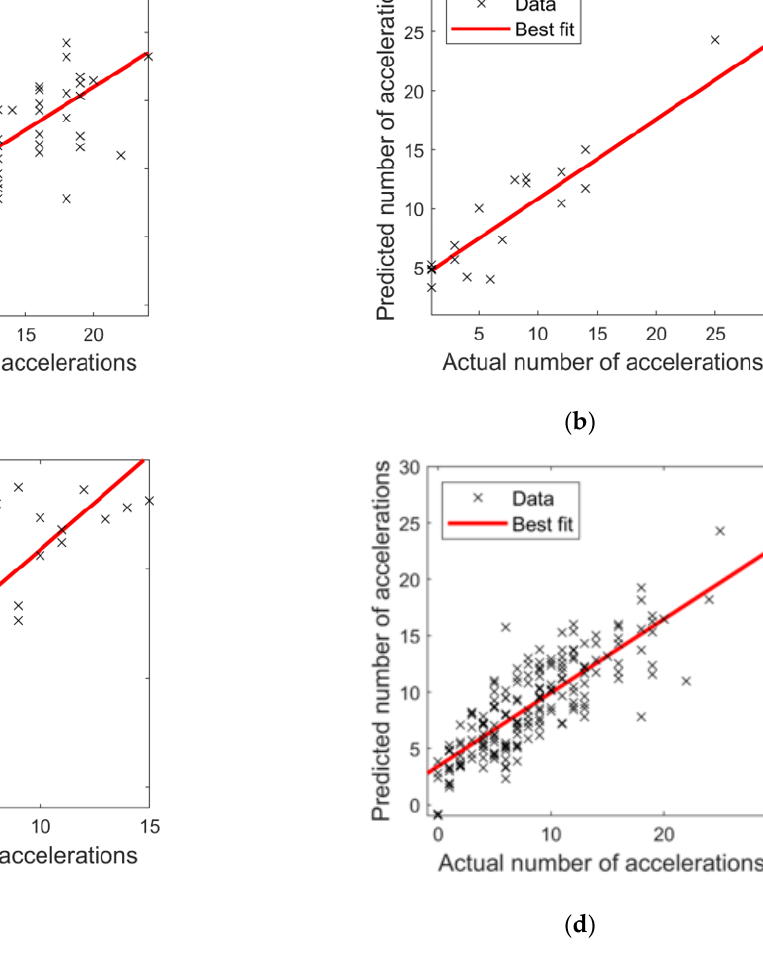
Figure 7. Scatter plots of the number of actual versus predicted accelerations for ( a ) the training subset; ( b ) the validation subset; ( c ) the test subset; ( d ) all data sets. The fitting line (solid) is also reported for each plot along with the identity (X = Y) line (dashed), used as a reference to represent the perfect agreement between real and predicted data.